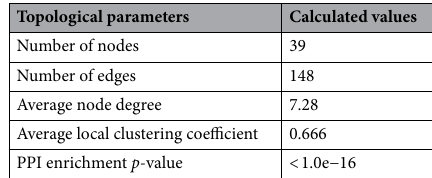
Table 5. Topological parameters for the PPI